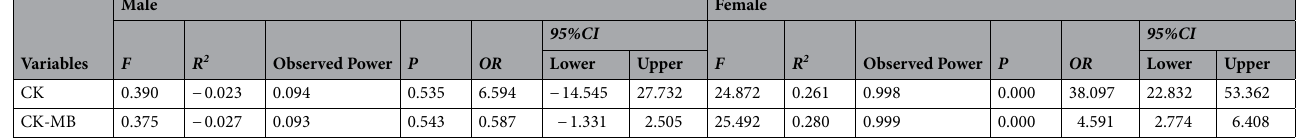
Table 4. Univariate covariance analysis results of elevated CK and CK-MB of PMDP compared to FDDP in male and female patients. The baseline level of CK or CK-MB was taken as a covariate.